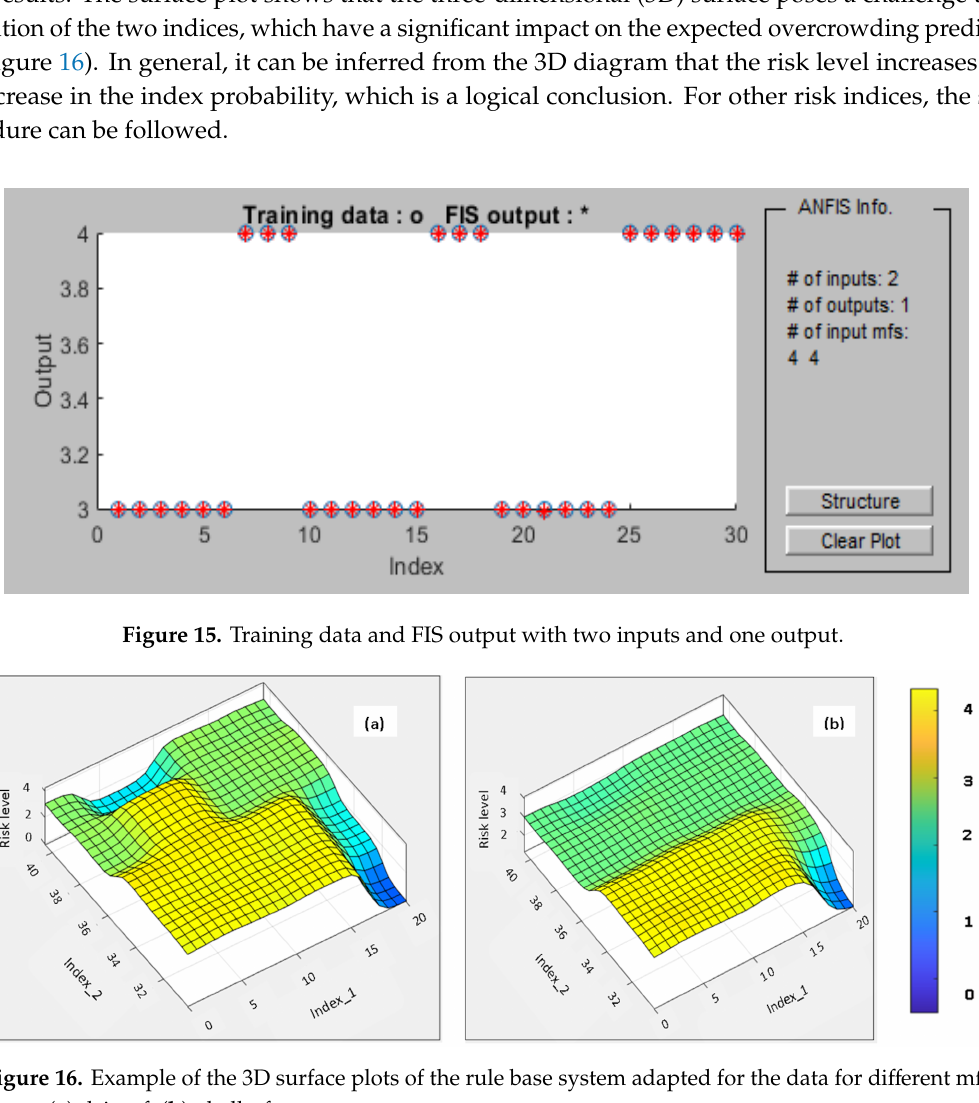
Figure 16. Example of the 3D surface plots of the rule base system adapted for the data for different mf types; ( a ) dsigmf, ( b ) gbellmf.